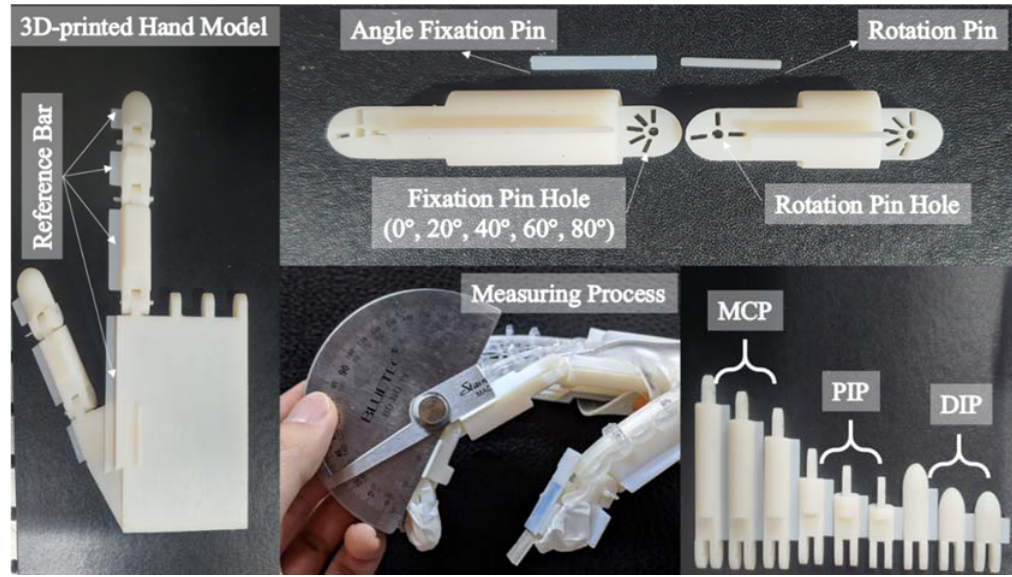
Figure 8. 3D printed hand model used for quantitative evaluation of the wearable hand